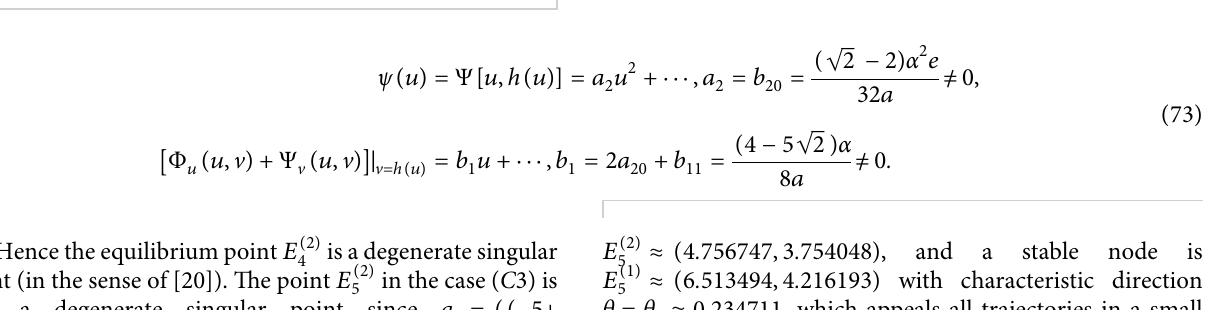
in the case (C2). (b) A cusp E ( 2 ) 4